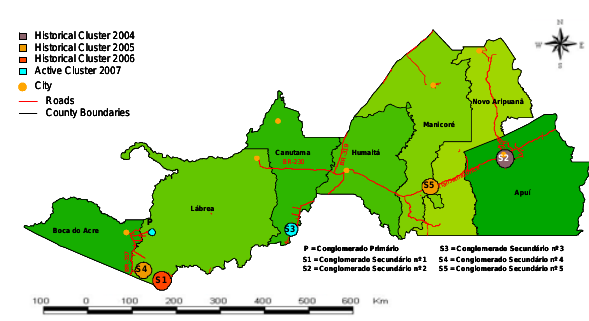
Figure 6. Retrospective analyses considering the distance to roads